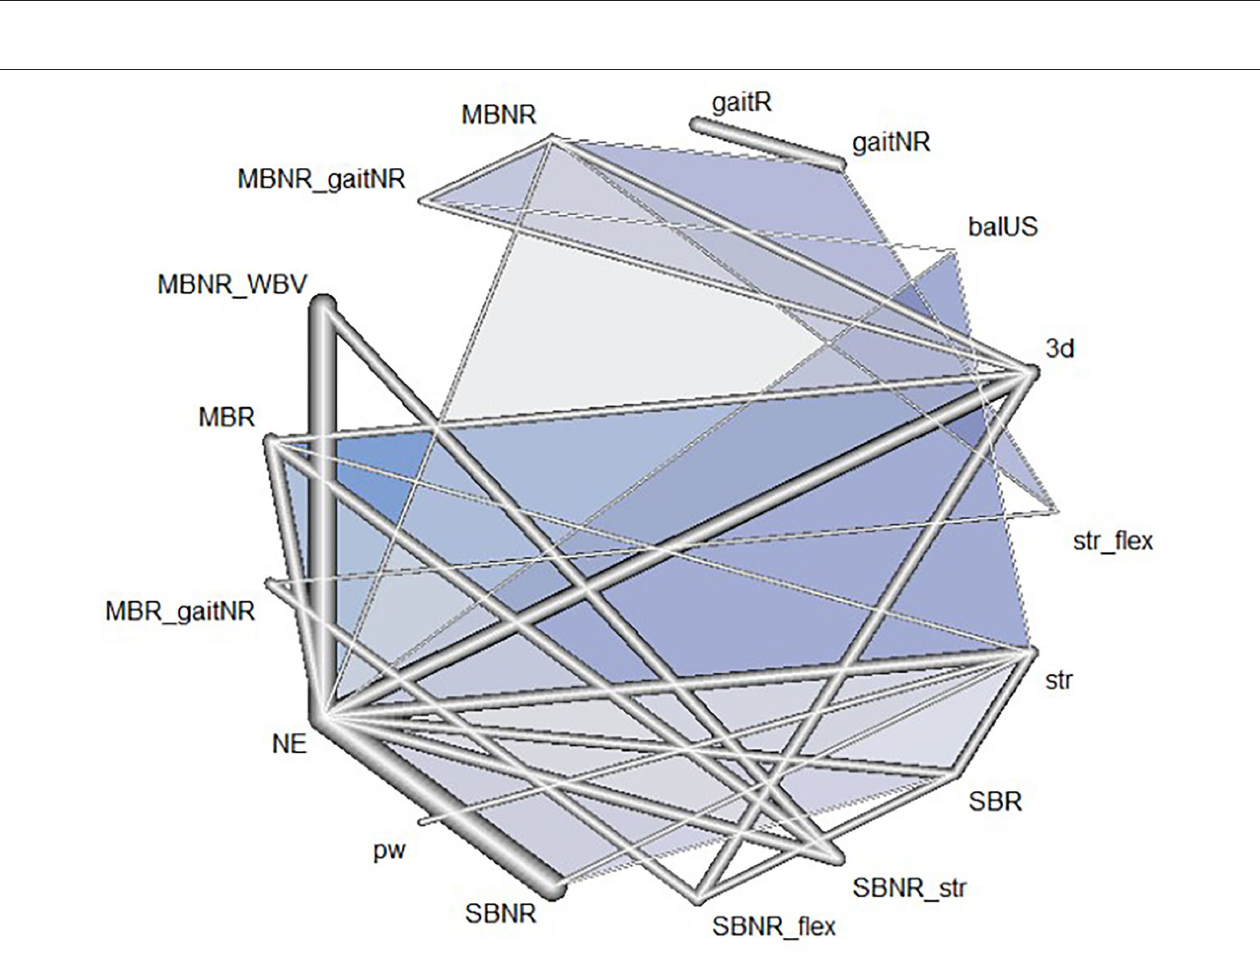
FIGURE 3 | Network geometry of the included exercise programs: Each line indicates a direct comparison of two different exercise programs. The thickness of the edge is proportional to the number of direct comparisons in the network. Different exercise types combined in one program are connected via underscores. The blue triangles refer to multi-arm trials comprised of three exercise programs in the nodes. SBR, Single balance exercise including reactive balance component; SBNR, Single balance exercise not including reactive balance component; MBR, Multiple balance exercises including reactive balance component; MBNR, Multiple balance exercises not including reactive balance component; balUS, Unspecified balance exercise; gaitR, Gait training including reactive balance component; gaitNR, Gait training not including reactive balance component; WBV, Whole body vibration; str, Strength; pw, Power; 3d, 3D exercise; flex, Flexibility; aer, Aerobic; NE, No exercise.